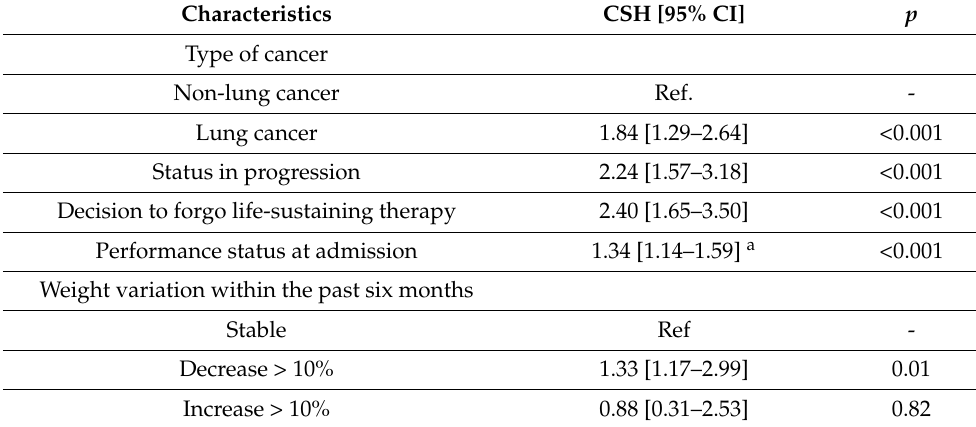
Table 4. Determinants of one-year mortality in the 368 ICU